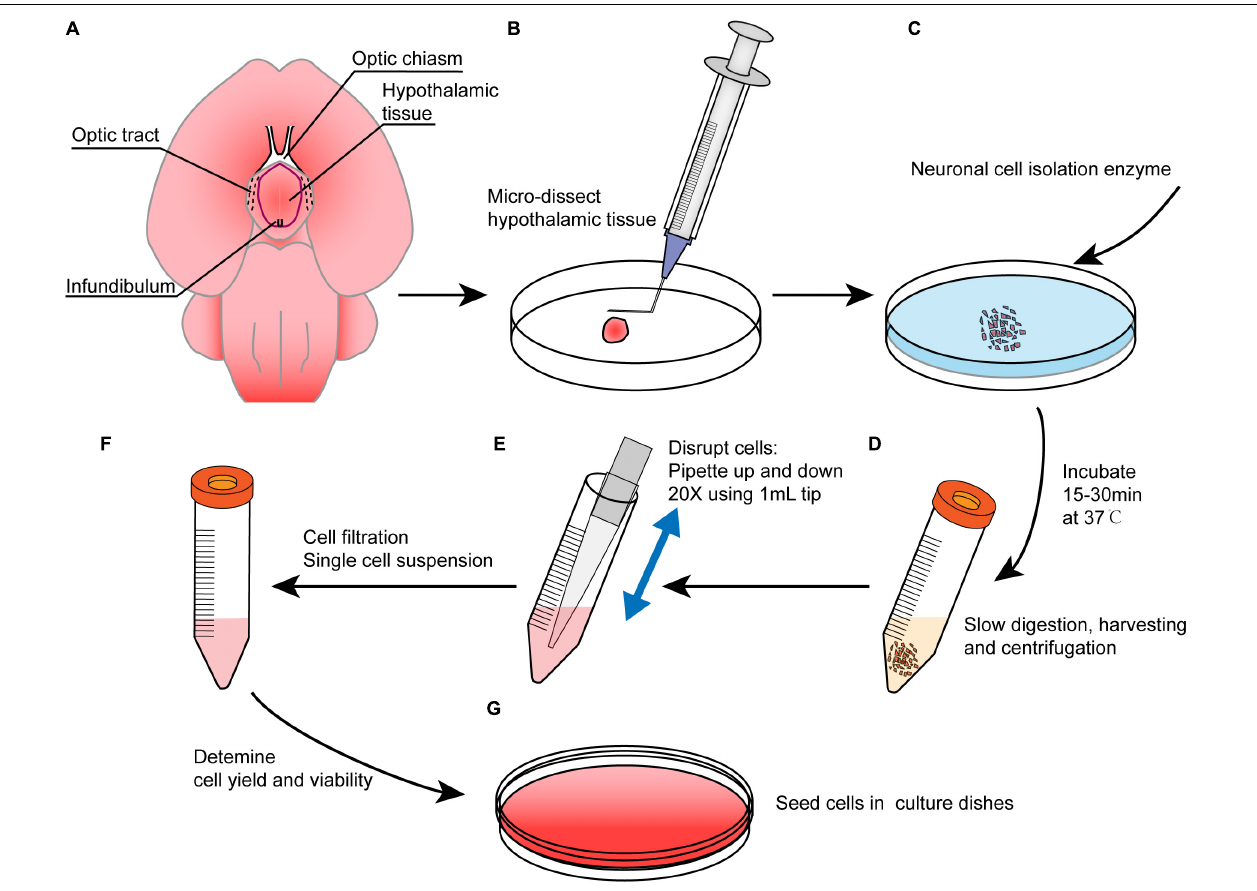
FIGURE 2 | An overview of the main procedures in this method. (A) Brain preparation in the ventral side-up position to show hypothalamic borders. Red line shows the dissection margins. (B) Brain microdissection was performed to obtain hypothalamus tissue, and the tissue was minced with a bent needle. (C) The tissue was digested with neuronal isolation enzyme at 37 ◦ C for 15–30 min. (D) The digestion reaction was slowed with DMEM followed by centrifugation, and the supernatant was discarded. (E) The pellet was resuspended in NSPC medium and triturated. (F) The cells were filtered to obtain a single cell suspension. (G) Cells were cultured in NSPC medium at a density of 1–3 × 10 5 cells/ml after a viability